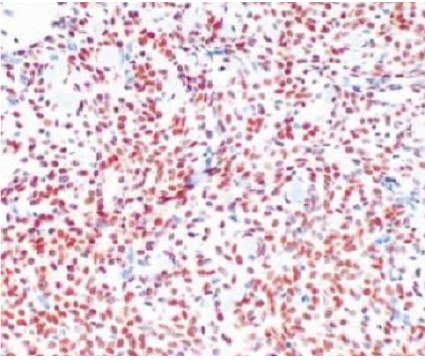
Figure 7: Immunohistochemistry picture showing progesterone receptor